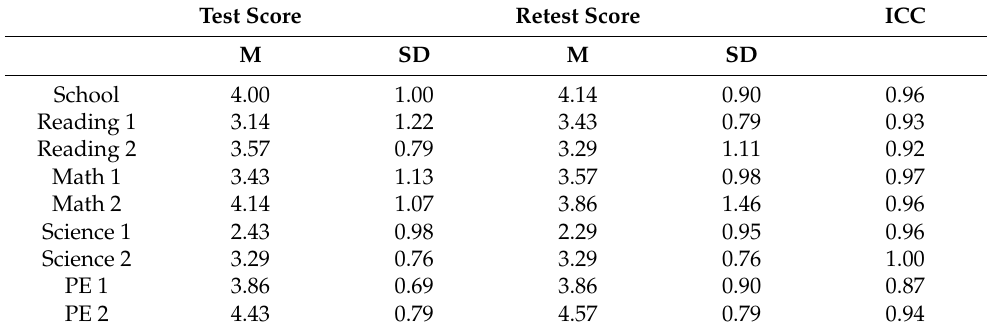
Table 2. Means and standard deviations of the test and retests scores (N=7).